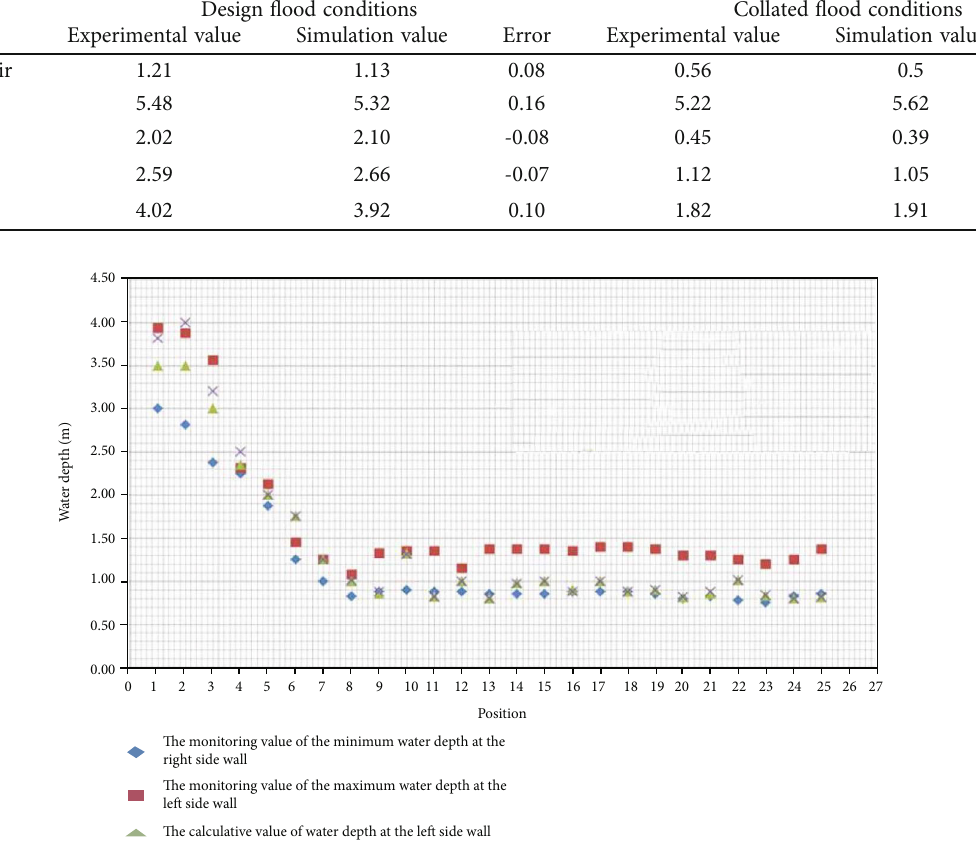
Figure 7: The comparison between numerical and experimental values of water depth at the side wall under the design fl ood level